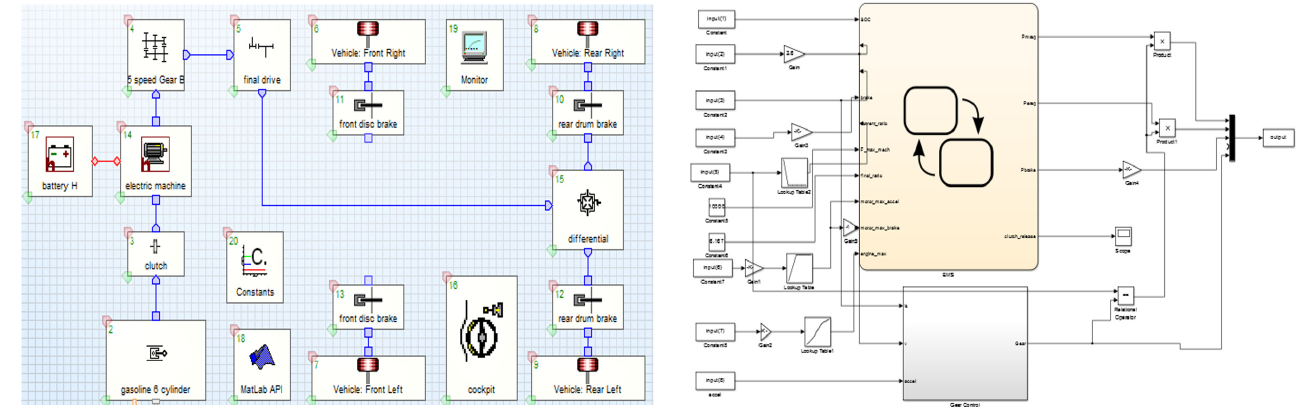
Figure 17. HEV model in Cruise and control strategy in Matlab/Simulink.